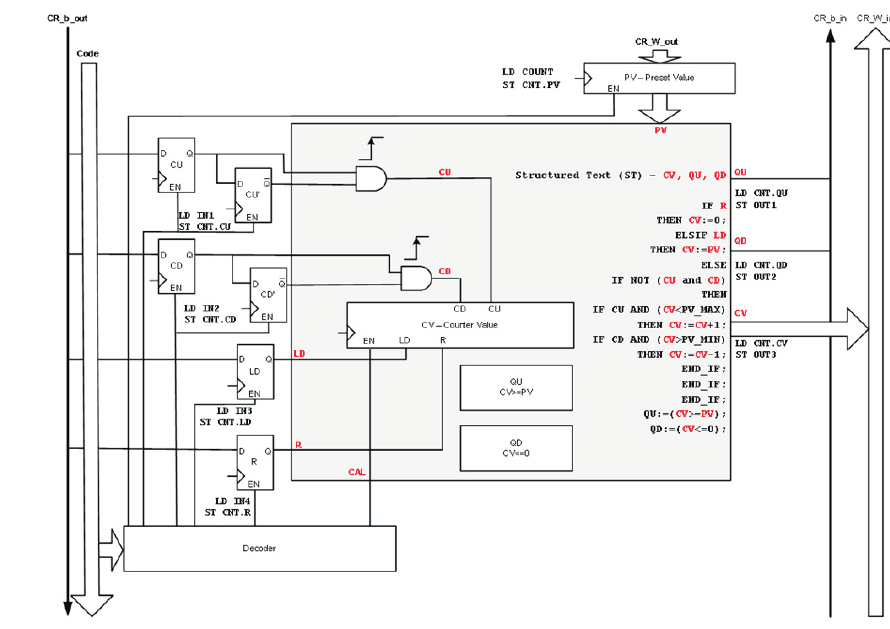
Figure 8. The structure of the hardware-based counter block with